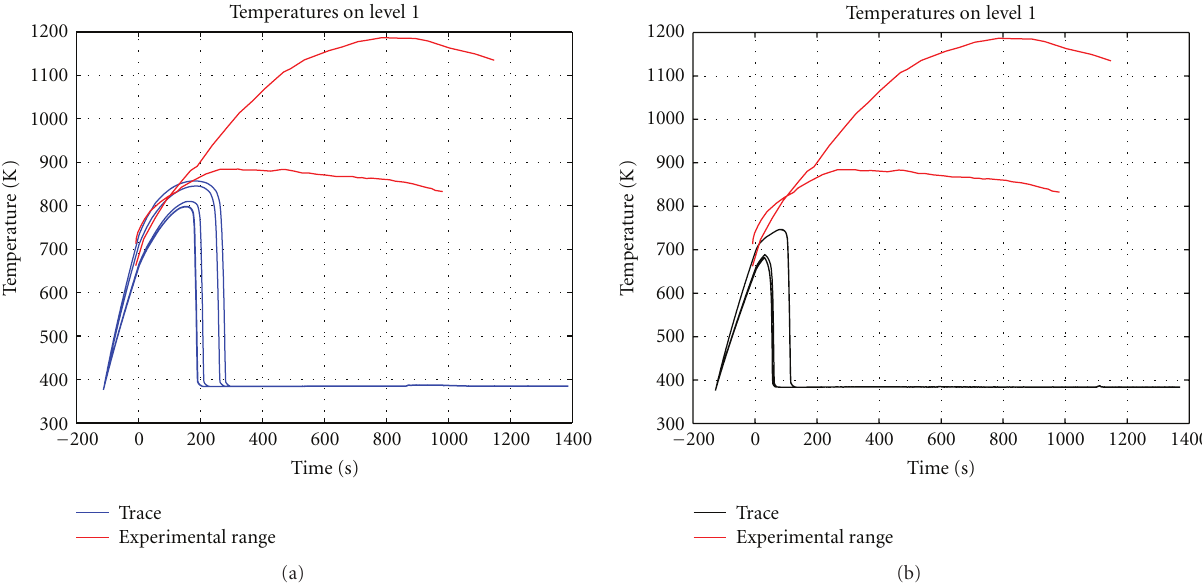
Figure 9: Temperatures computed from the PIPE model (a) and CHAN model (b) at Level 1.